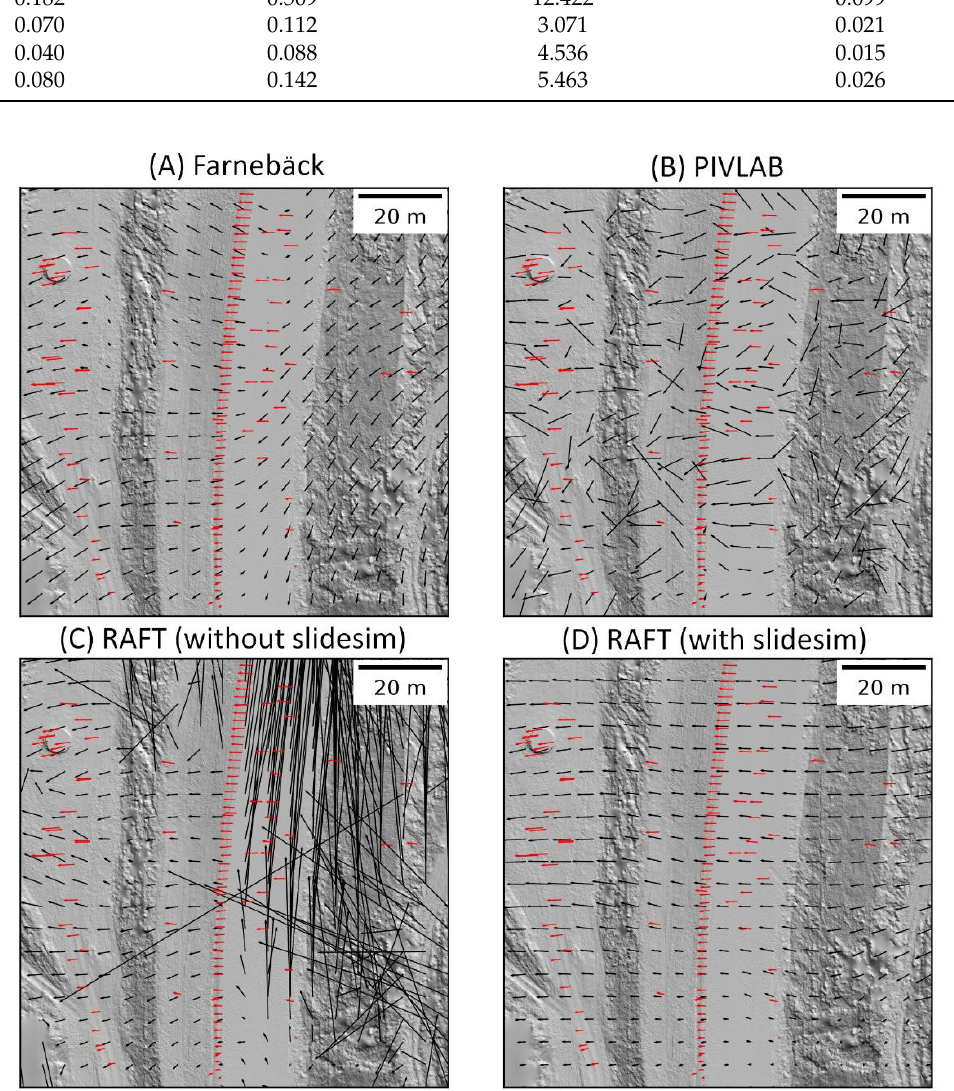
Figure 6. Visualization of 2D landslide displacement mapping using 4 different methods: ( A ) Farnebäck optical flow, ( B ) PIVLAB, ( C ) RAFT without SlideSim , and ( D ) RAFT with SlideSim . Black vectors show the predicted 2D displacement vectors plotted every 100 cells, while the red vectors show the ground truth vectors measured from the ground truth dataset. All vectors are scaled 20×.